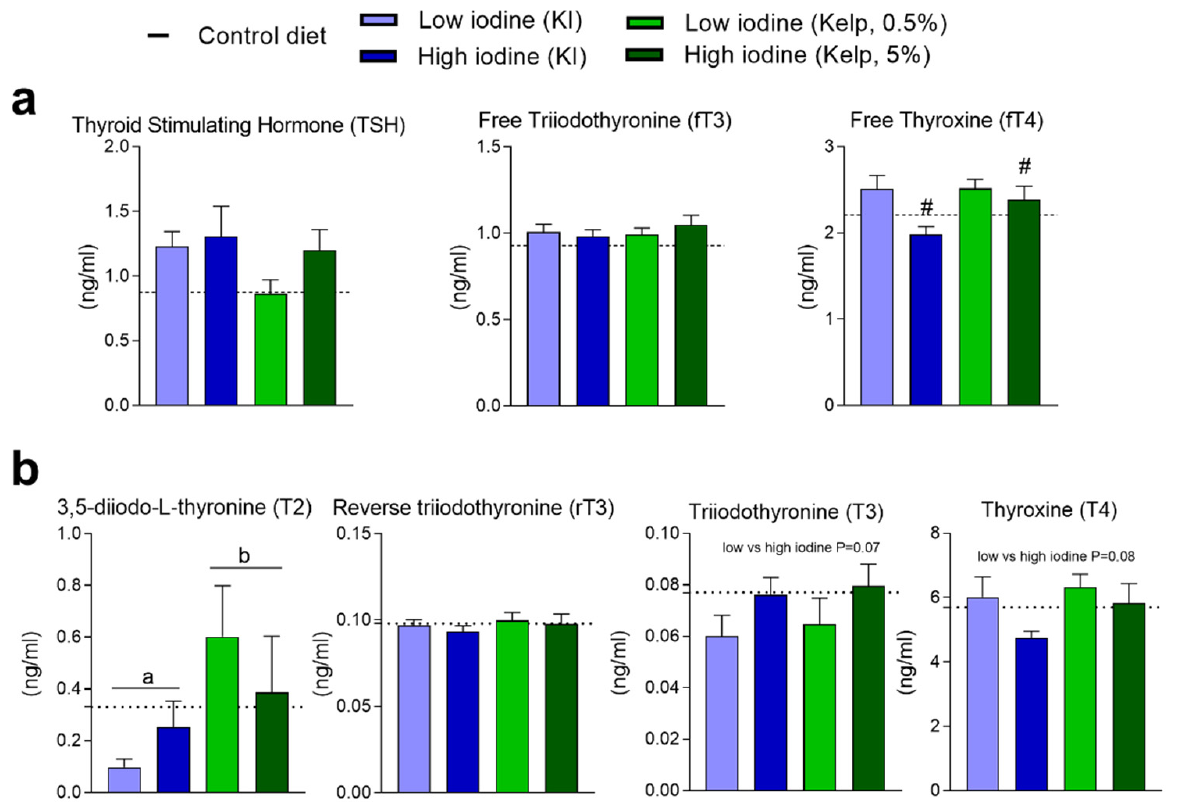
Figure 5. Plasma levels of thyroid hormones after 13 weeks of dietary treatment. ( a ) TSH, fT3, and fT4 analysed with ELISA. ( b ) 3,5-Diiodo-L-thyronine (T2), rT3, T3 and T4 analysed with nanoLC- HRMS/MS. Data are presented as mean ± SEM ( n = 6–10). Different letters (a,b) in the graph denote significant differences ( p < 0.05) between the iodine sources (kelp, KI), with # indicating significant differences between the iodine doses (independent of source). Data were analysed using a standard two-way ANOVA in GraphPad Prism.